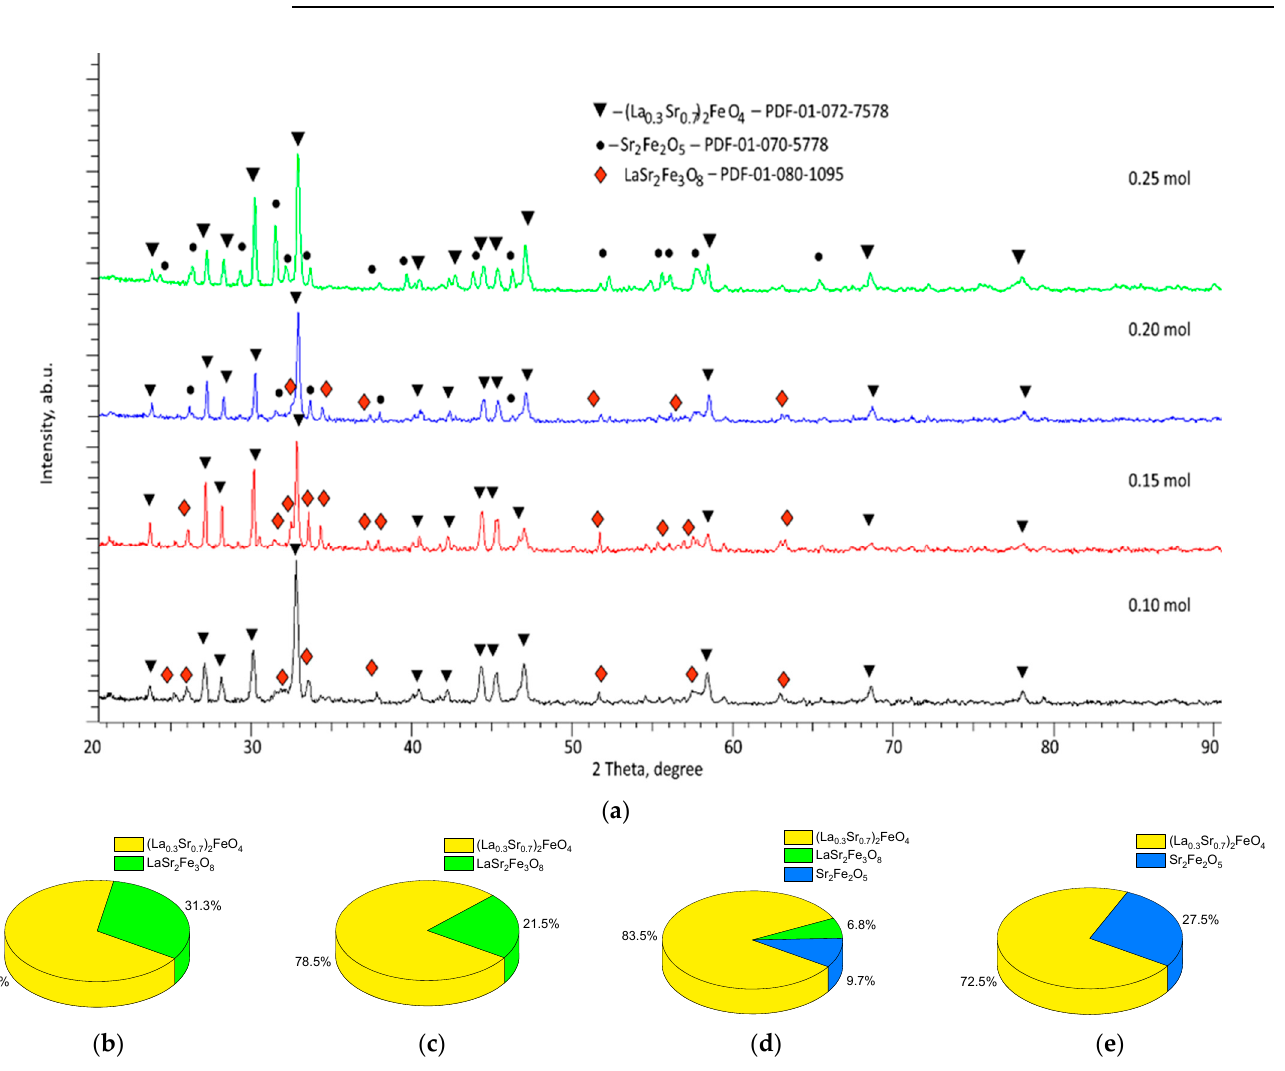
Figure 3. ( a ) X-ray diffraction patterns of synthesized ceramics based on lanthanum strontium ferrite depending on the lanthanum concentration; phase diagrams of the synthesized ceramics depending on the lanthanum concentration: ( b ) 0.10 mol; ( c ) 0.15 mol; ( d ) 0.20 mol; ( e ) 0.25 mol.